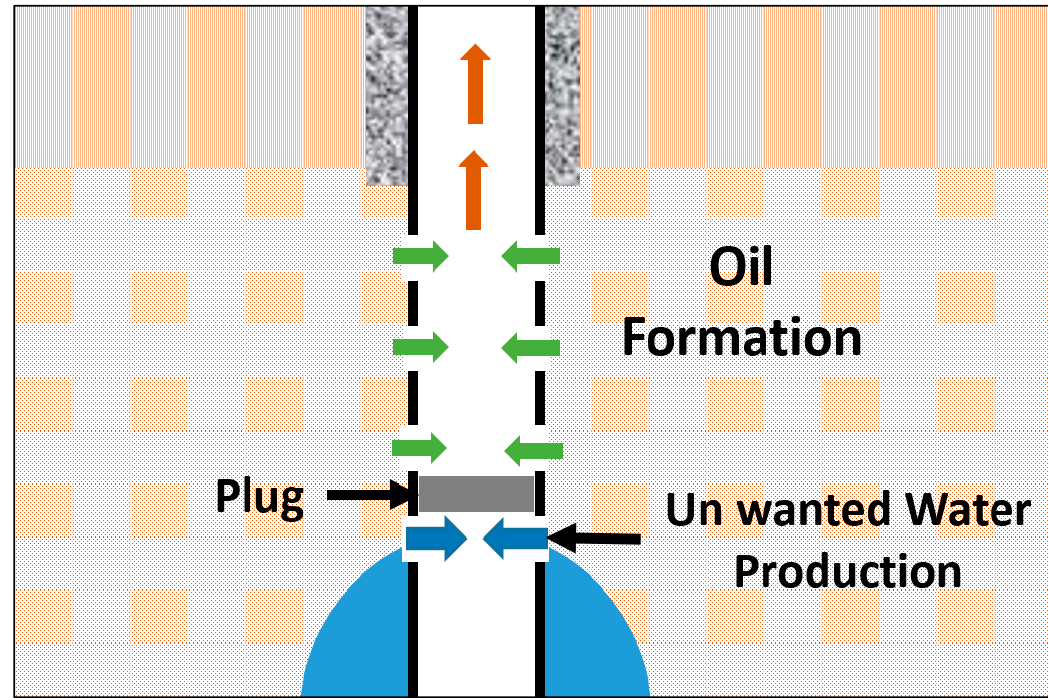
Figure 6. Using a plug to shut off the production of water from the bottom.